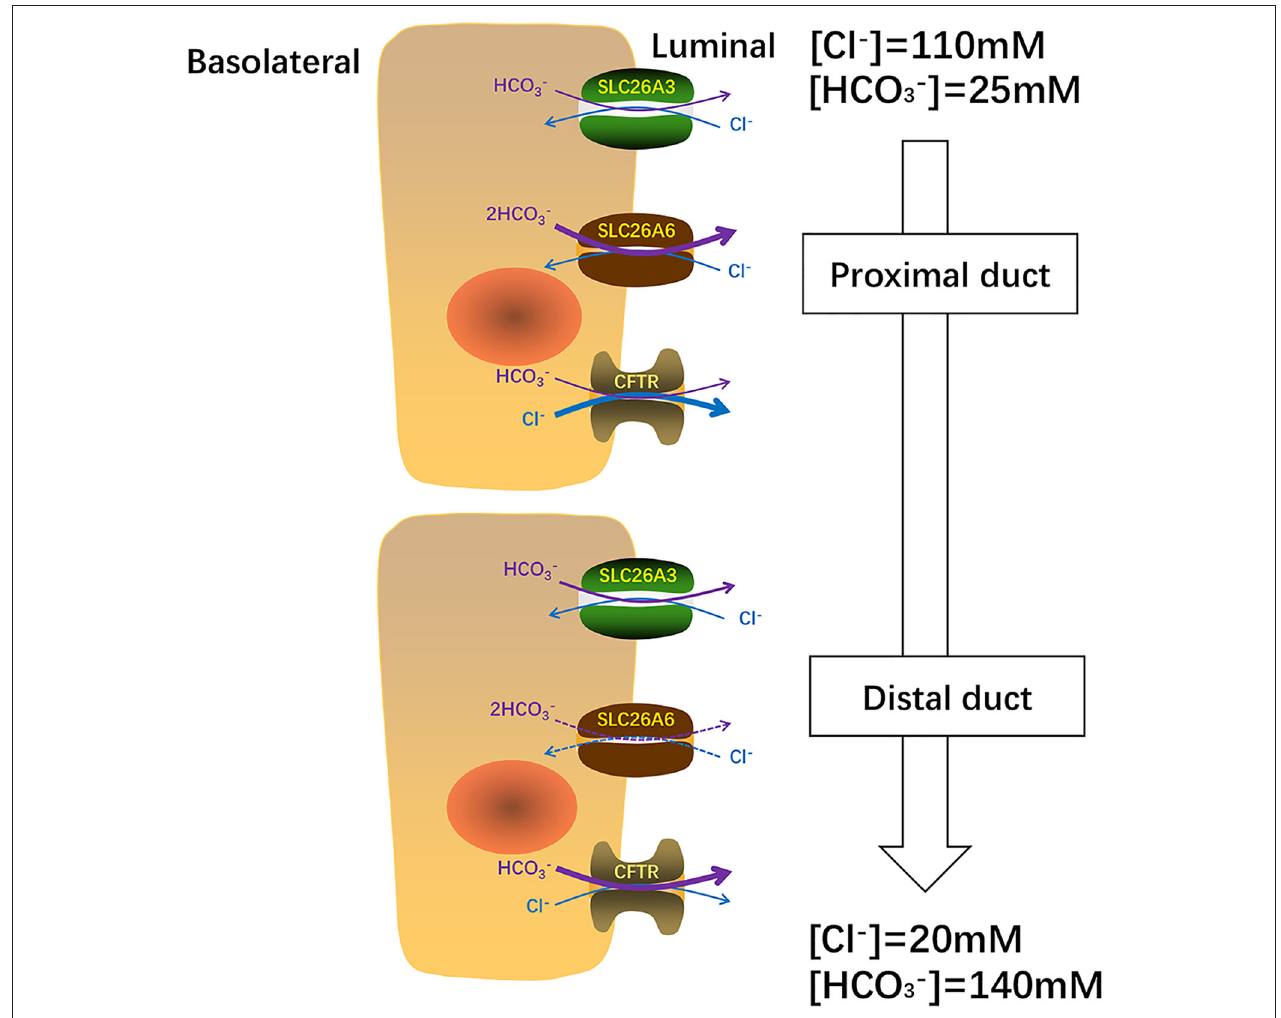
FIGURE 3 | In pancreas, SLC26A6 and SLC26A3 perform their functions at different ion concentrations. SLC26A6 is predominantly responsible for the excretion of basal HCO − 3 and CFTR is primarily responsible for Cl − secretion from the proximal duct. Close to the distal tubule, the concentration of HCO − 3 increases, SLC26A3 plays a major role in the secretion of basal HCO − 3 . When the concentration of HCO − 3 in the distal tubule reaches a maximum of 140 uM, the secretion of HCO − 3 mainly depends on